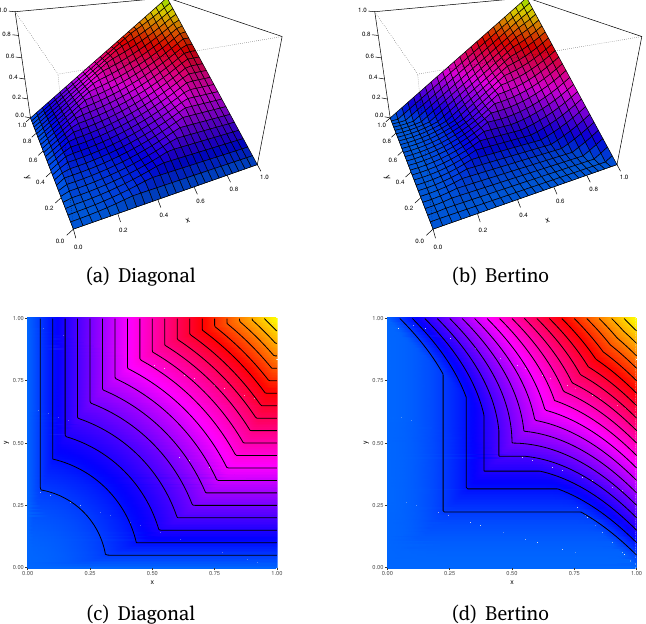
with diagonal δ ( t ) = t 2 , and in the second row their corresponding y C Ber δ δ